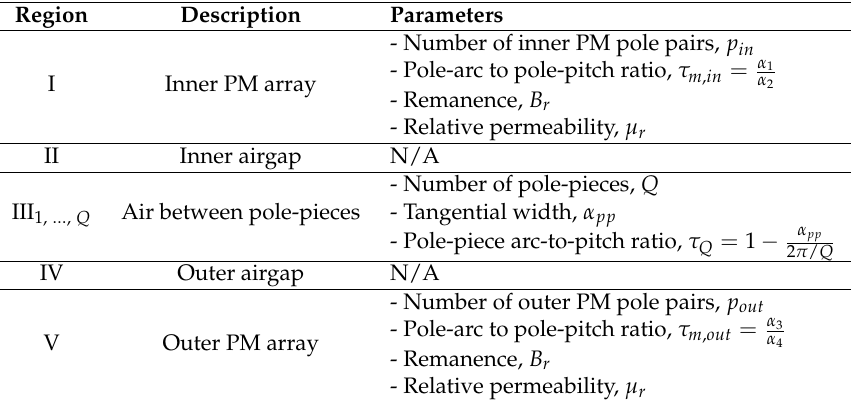
Figure 7. Representation of the magnetic gear structure for modeling purpose. Table 4. Modeled regions in the magnetic